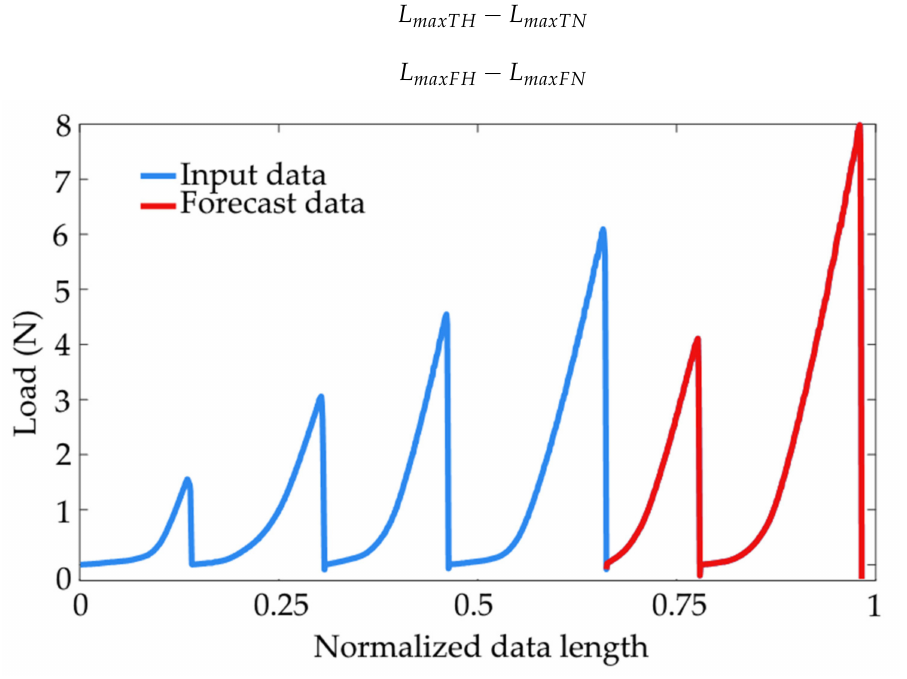
Figure 6. Range of forecast-processed